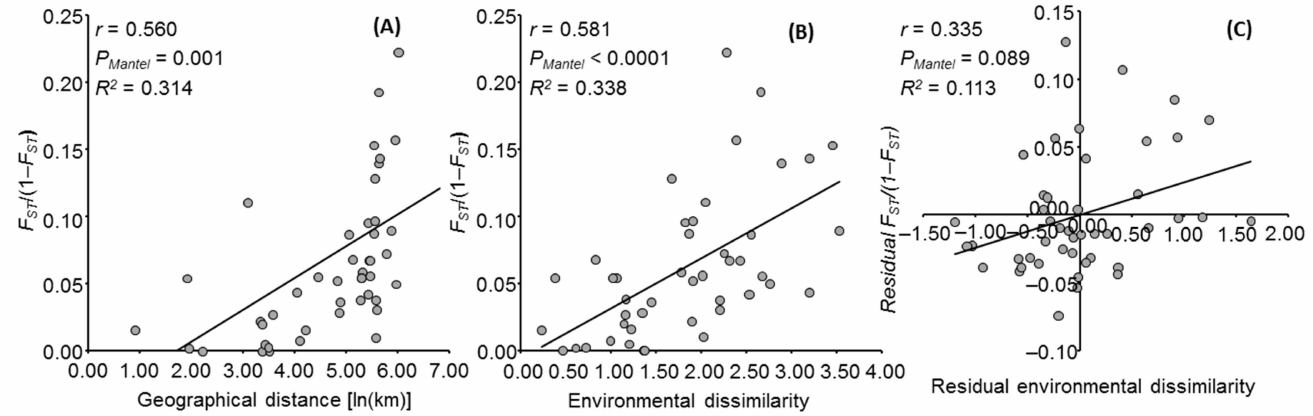
Figure 6. Isolation by distance and isolation by environmental distance. Plots of Mantel’s test showing the relationships between the geographical and genetic distances ( A ), the environmental and genetic distances ( B ), and the residual environmental and genetic distances ( C ) by taking into account the geographical distances among ten Micromeria croatica